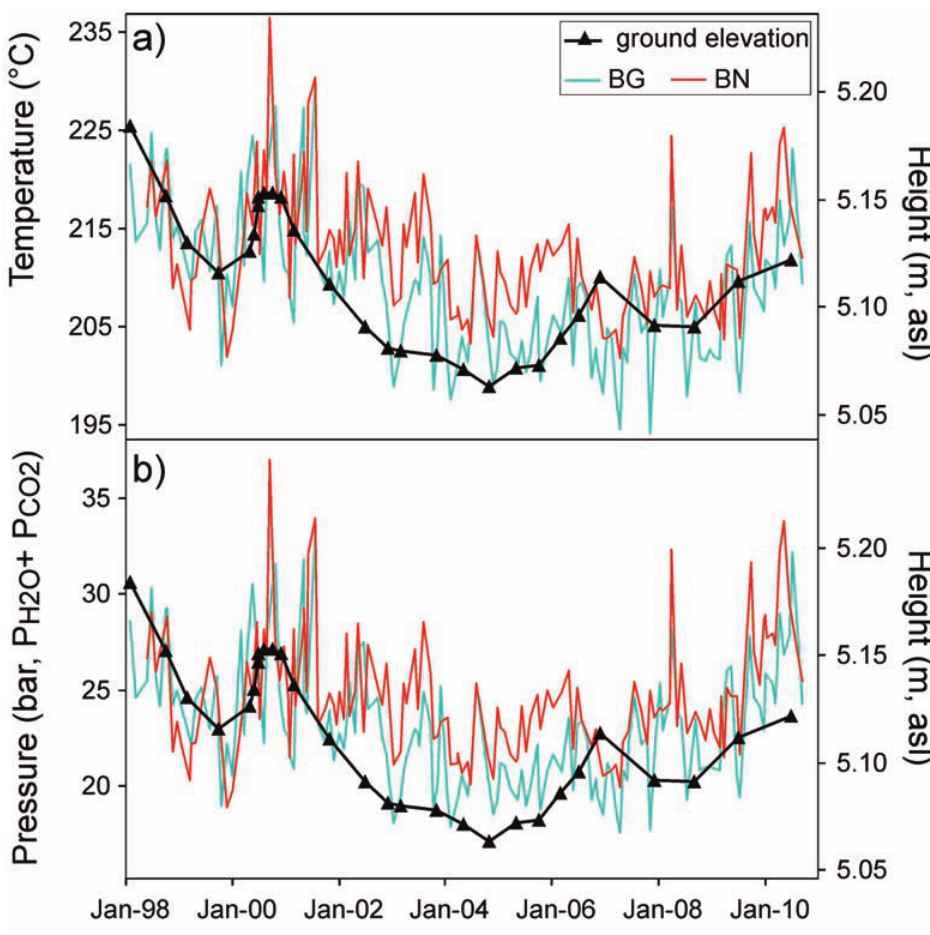
Figure 9. Chronogram of vertical ground displacement, as recorded at benchmark 25 (in Pozzuoli) and temperature (a) and pressure(b) for the BG and BN fumaroles. The similar shapes of the geochemical signals and the ground elevation suggest a possible relationship between them.